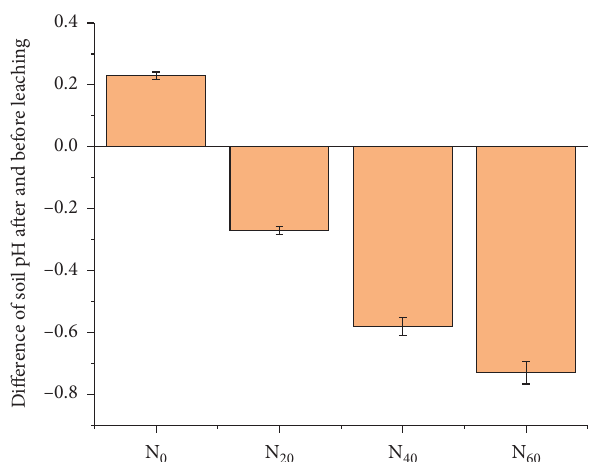
Figure 5: Changes of soil pH after and before leaching at different N deposition levels.